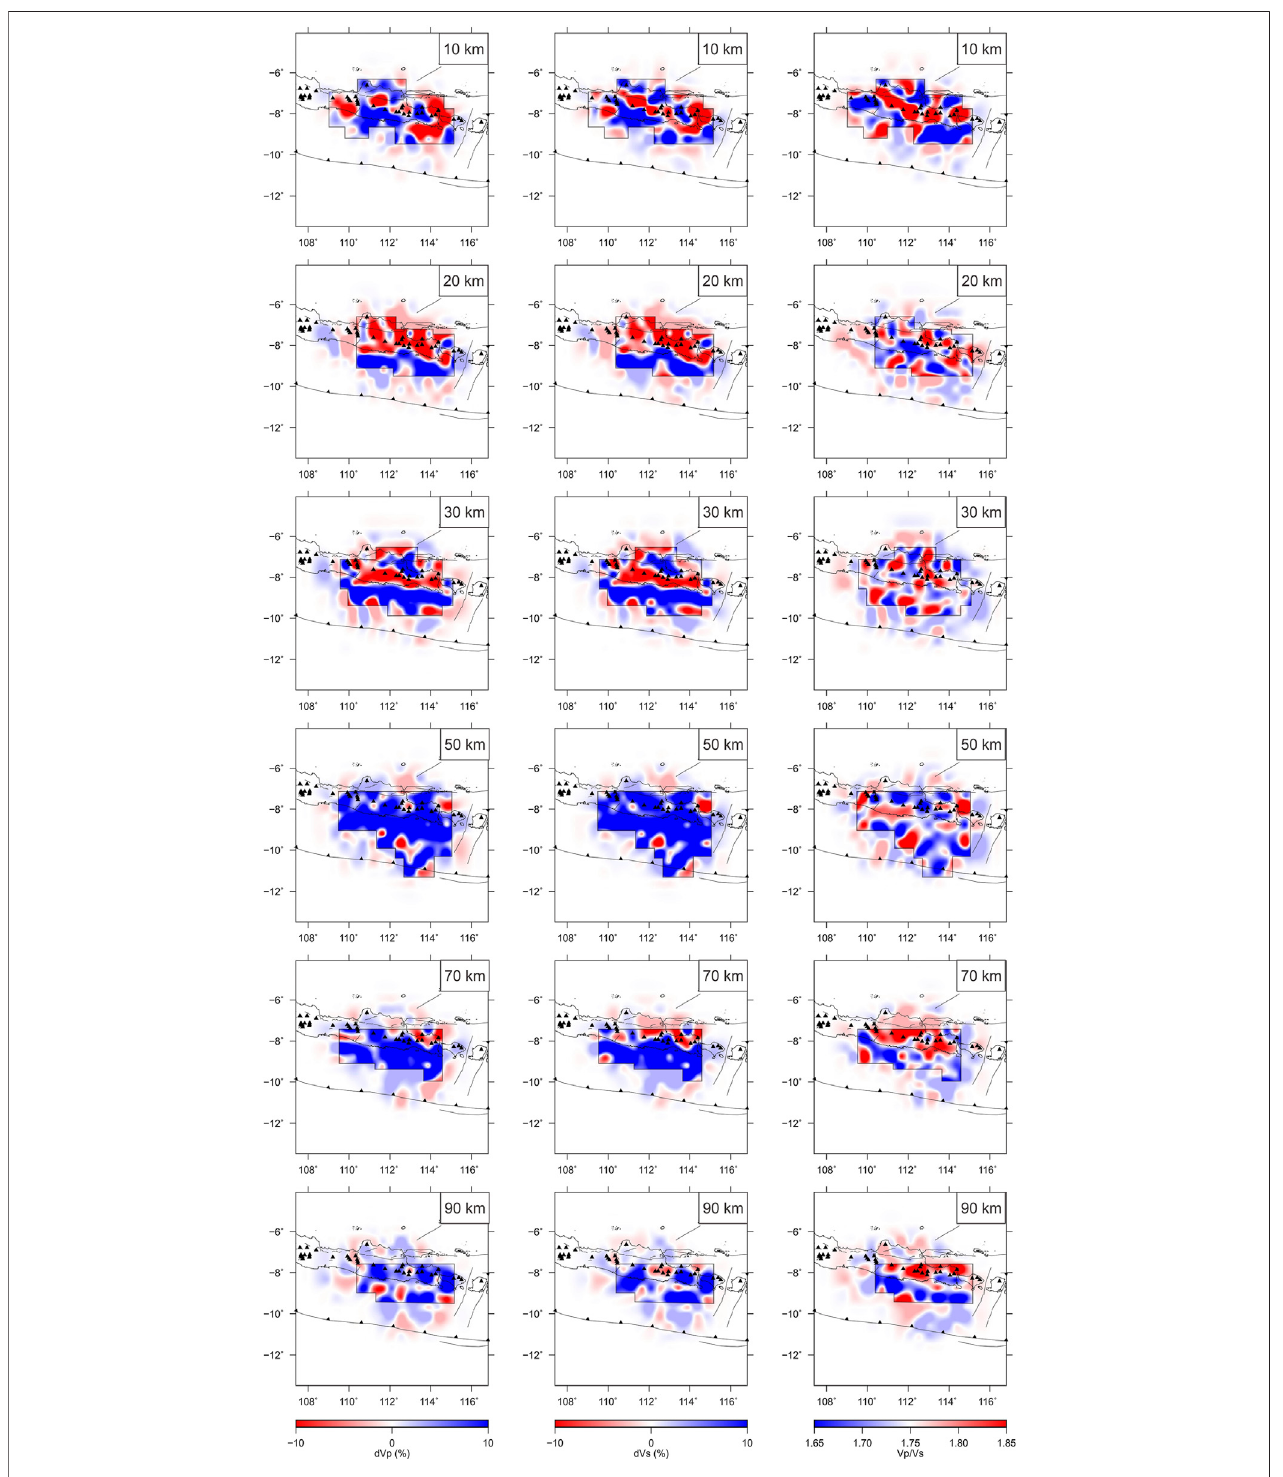
FIGURE4| Horizontalsections forVp,Vs,and Vp/Vsratioresultingfromtomographicinversionsatdepths10 – 90 km.Dashedpolygonsaretheareaswithreliable velocity structure results in this study. Red lines and triangles indicate the faults and volcanoes, respectively.